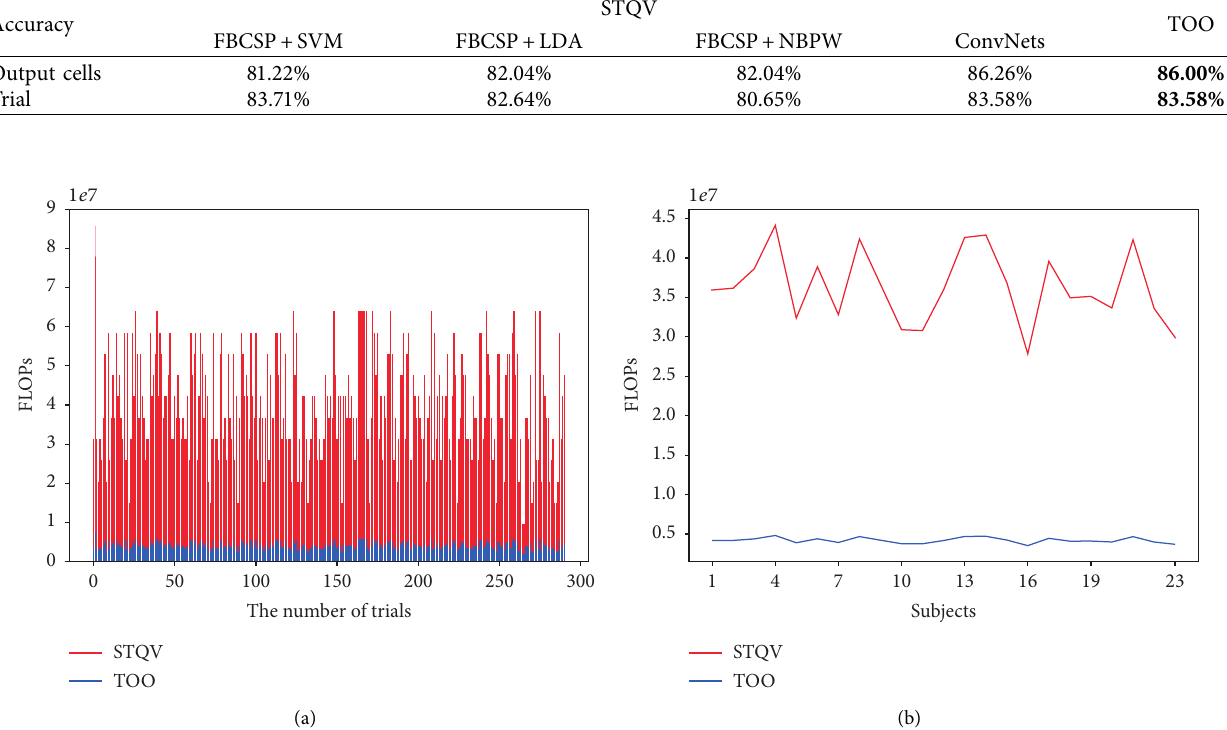
Figure 7: (a) The FLOPs charts of trials; (b) the FLOPs charts of